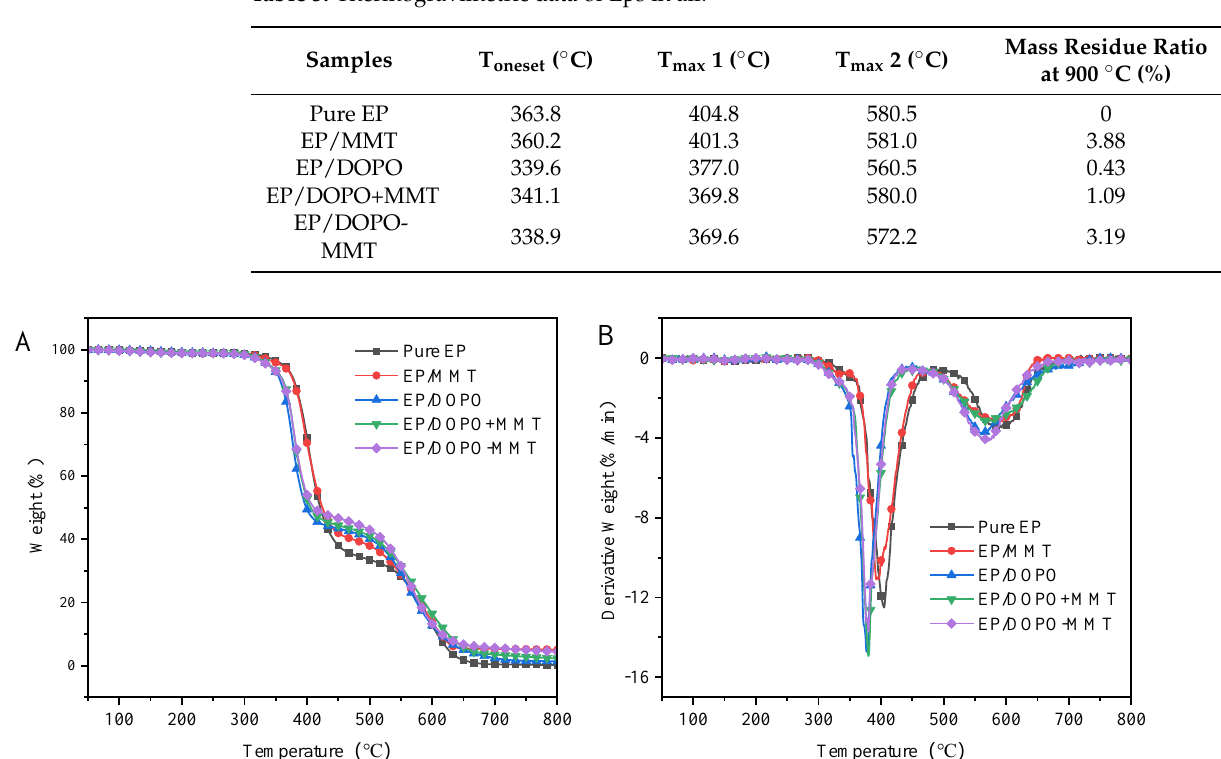
Table 3. Thermogravimetric data of Eps in air.